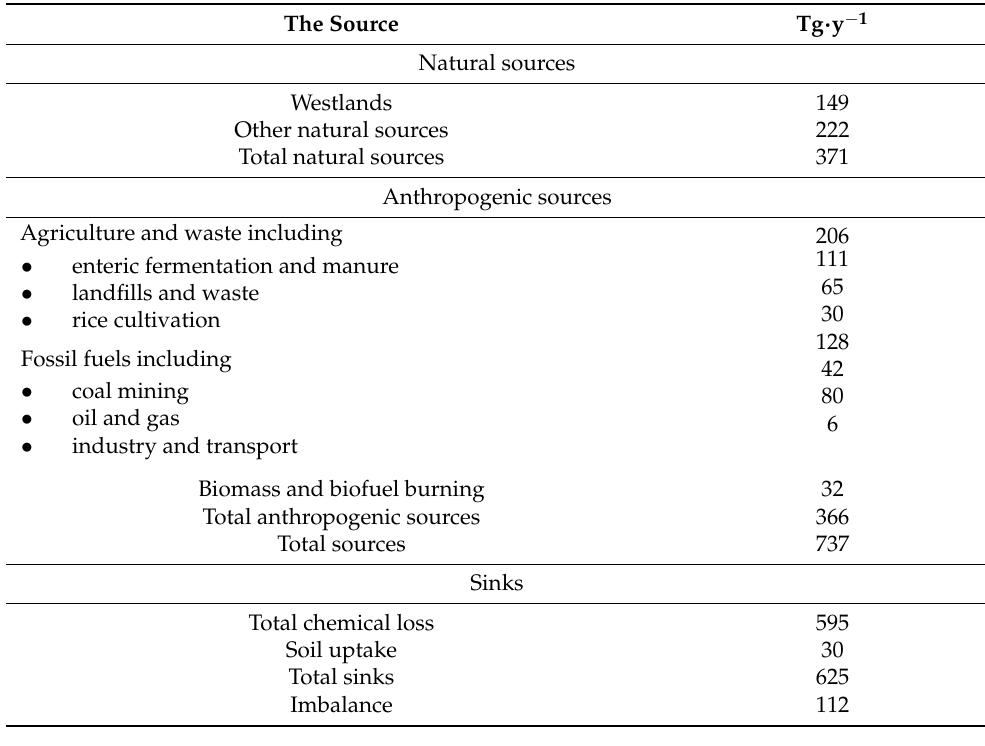
Table 1. Global methane emissions and